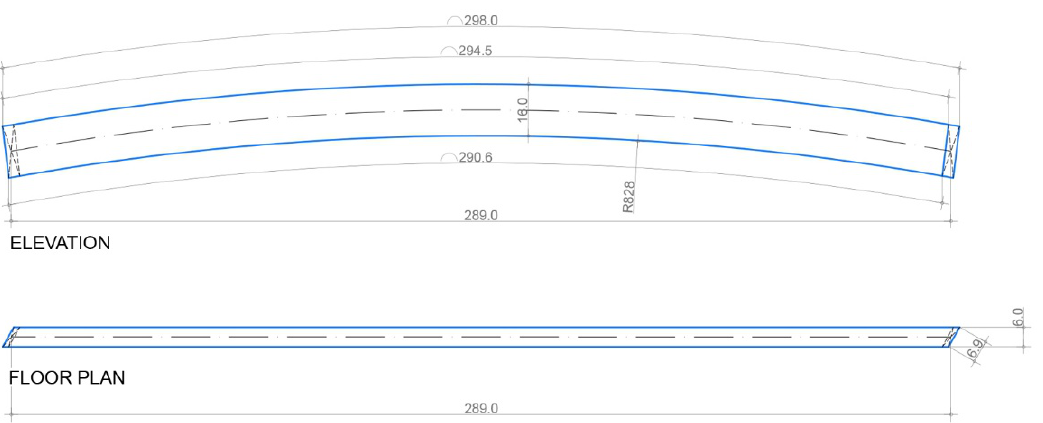
Figure 4. The shape of one lamella in floor plan and elevation, with an arched shaped axis. This drawing presents one typical lamella for a timber lamella vault, where all the axes of the lamellae intersect and the lamella axis is a planar arch.